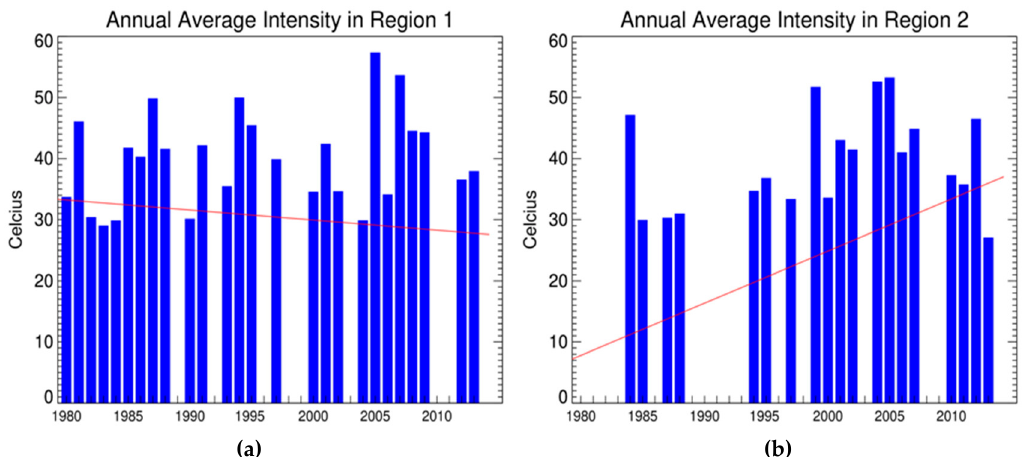
Figure 7. Annual average of the intensity (°C) of heat wave events in regions ( a ) 1 and ( b ) 2. The red line represents the trend of the intensity of the heat waves over the years. Atmosphere 2019 , 10 , x FOR PEER REVIEW